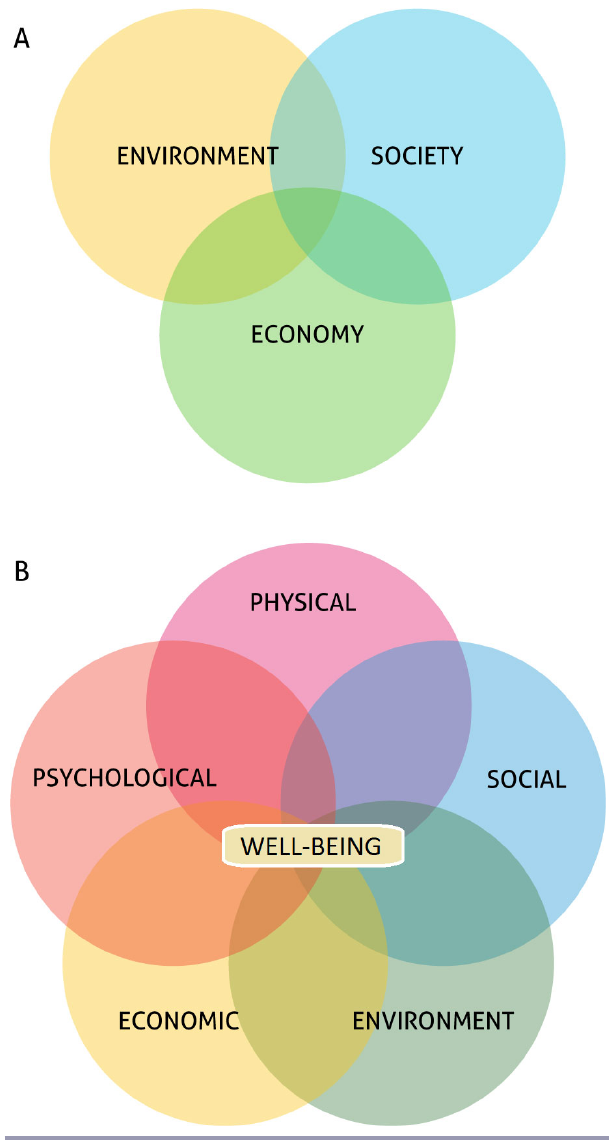
Fig. 2 . Conventional views of environment in development. (A) The three pillars of sustainability namely economy, society, and environment of the WCED (1987) and (B) five factors behind human well-being as often portrayed in the development